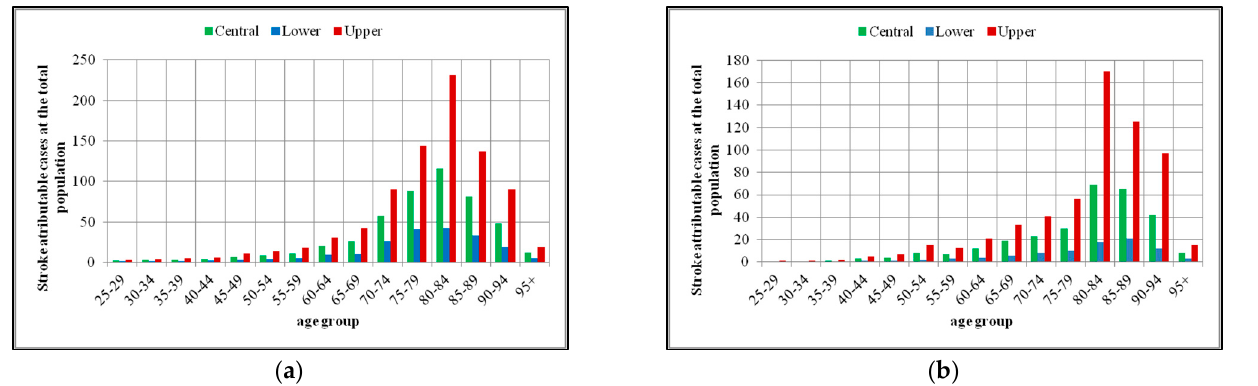
Figure 4. Stoke mortality cases (at the total population) per age group attributable to PM 2.5 exposure for ( a ) 2007 and ( b ) 2018.